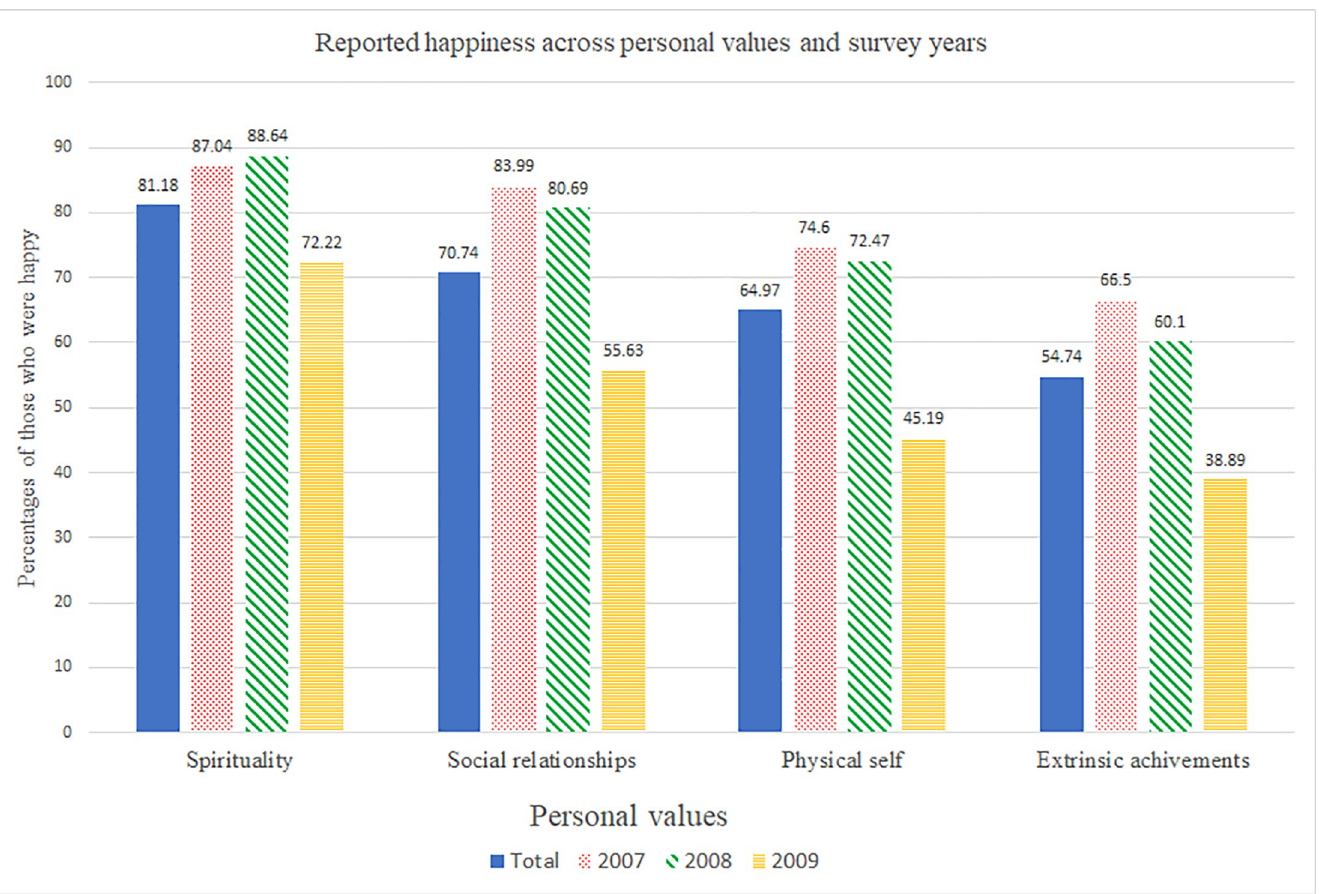
Fig 1. Percentages of respondents who reported being happy across valued life domains and survey